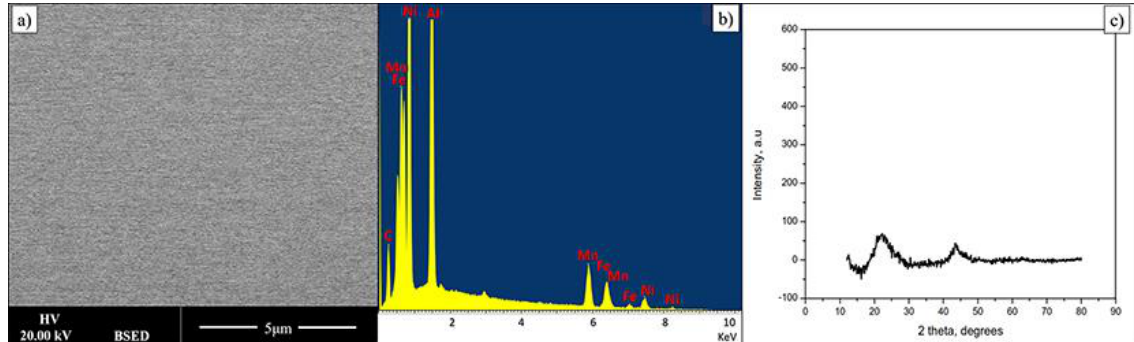
Figure 3. ( a , b ) BSE image and its EDX spectrum displaying a single phase of FeMnNiAlC 10 HEATF, ( c ) is the film XRD pattern.